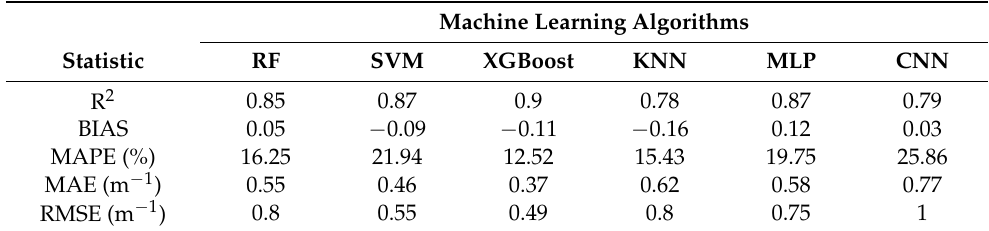
Table 2. Validation results of the six machine learning algorithms determined from the test